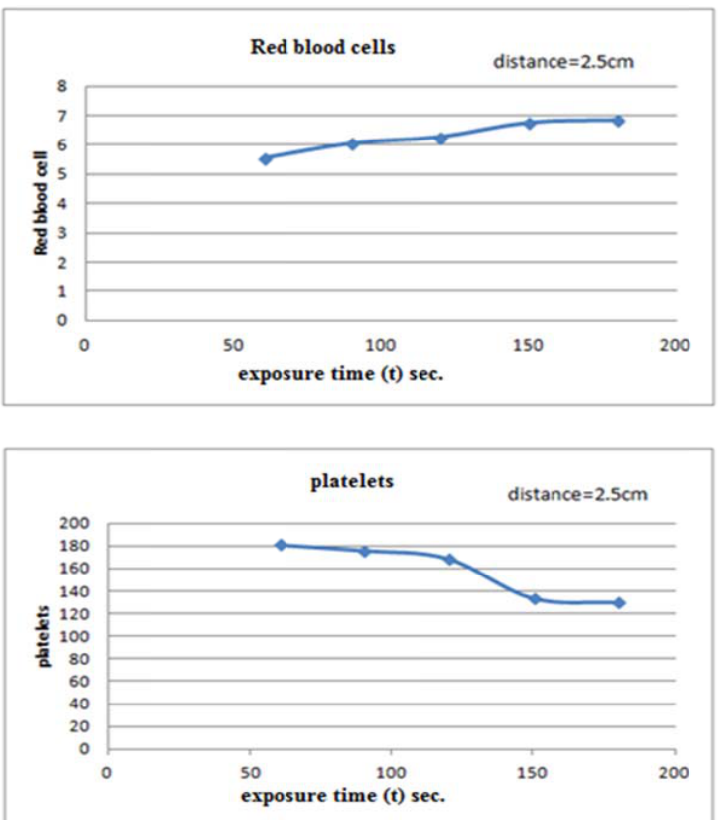
ffect of argon n plasma on